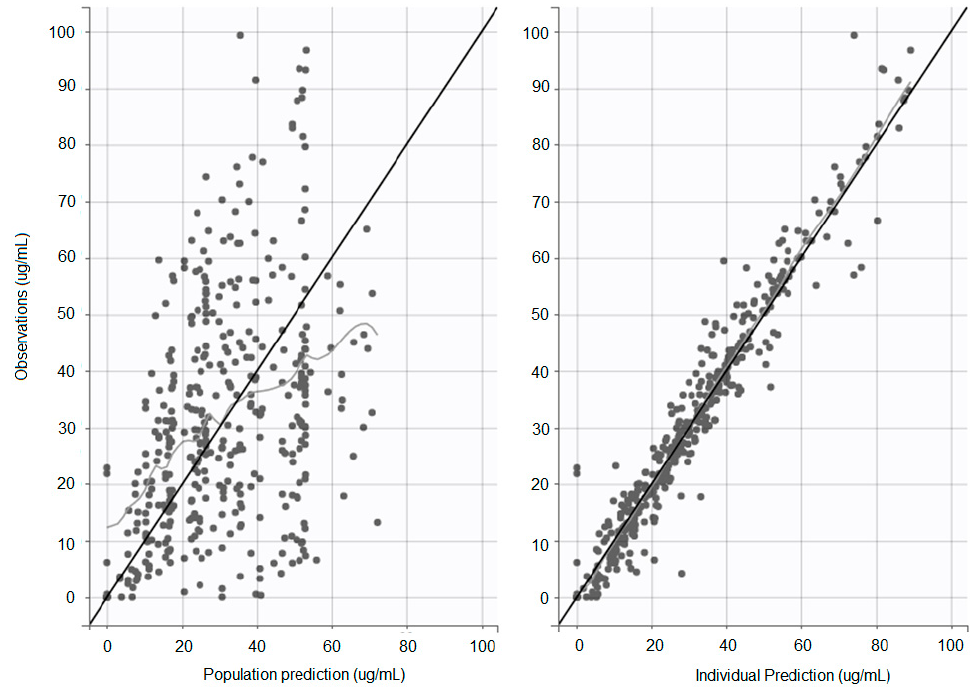
Figure 1. Observation vs. population and individual prediction.